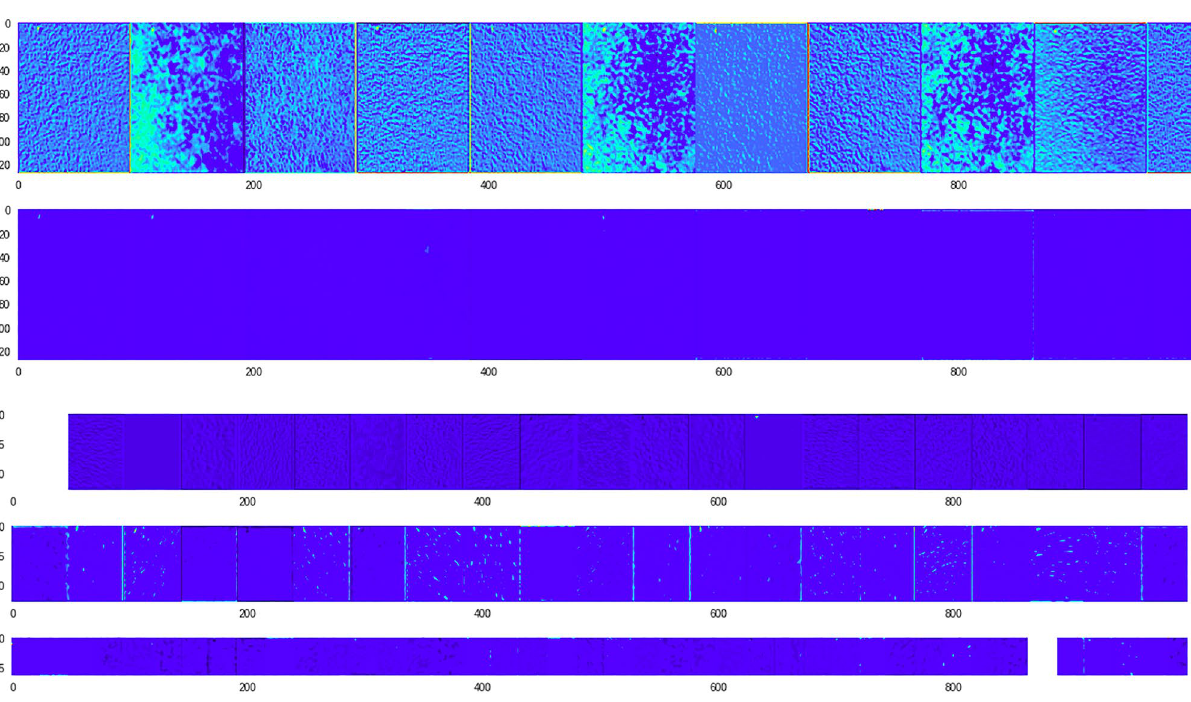
Figure 21. Convolution layers of the image in previous figure (Fig. 20) within the VML. No specific identifying feature has persisted till the last few convolution layers (Figure generated by Matplotlib python library, version 3.3.4, https:// matpl otlib.